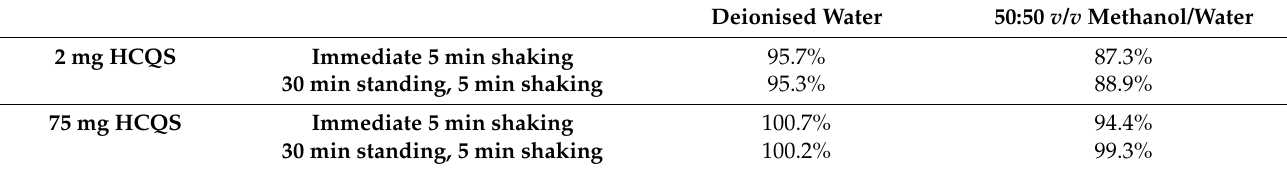
Table 3. Recovery of HCQS from spiked SureGard filters.